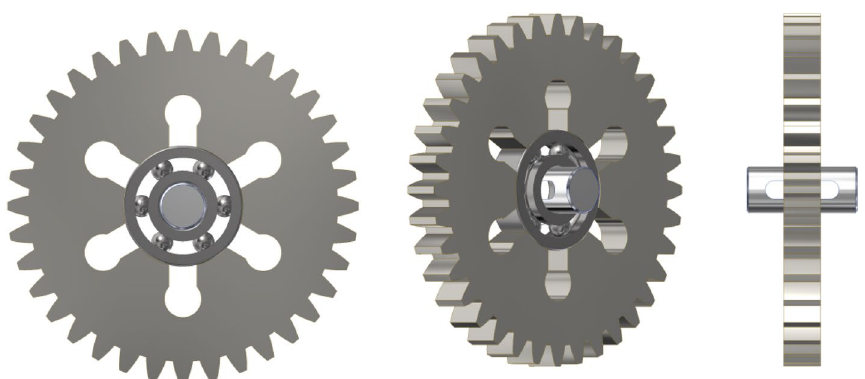
Figure 4. Views of the planet gear of the first stage gearset, with the bearing and